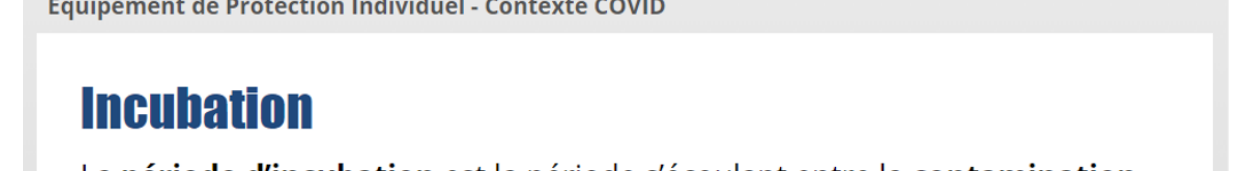
Figure 2. Mechanism preventing users from moving forward without completing the interaction. The learner clicked the Valider (Validate My Answer) button but could not proceed further because the virus had not been placed on the